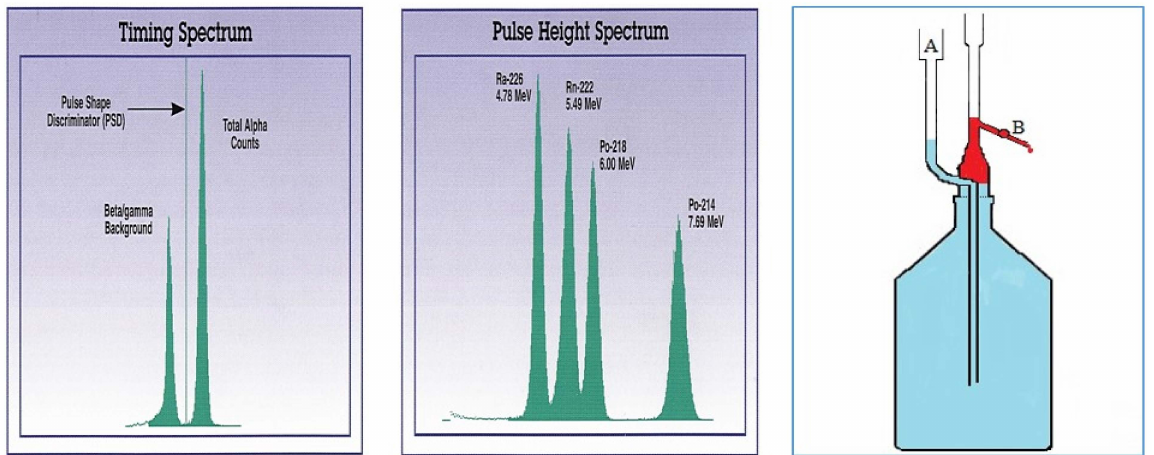
Figure 3. ( Left ): Pulse shape spectrum of a 226 Ra standard (78 Bq). The PSD is set left from the alpha peak. Middle: Pulse height spectrum of the same 226 Ra standard with daughter nuclides in equilibrium (taken from [19] with kind permission of ORDELA Inc). ( Right ): Extraction bottle with phase separator (red: separated cocktail phase)